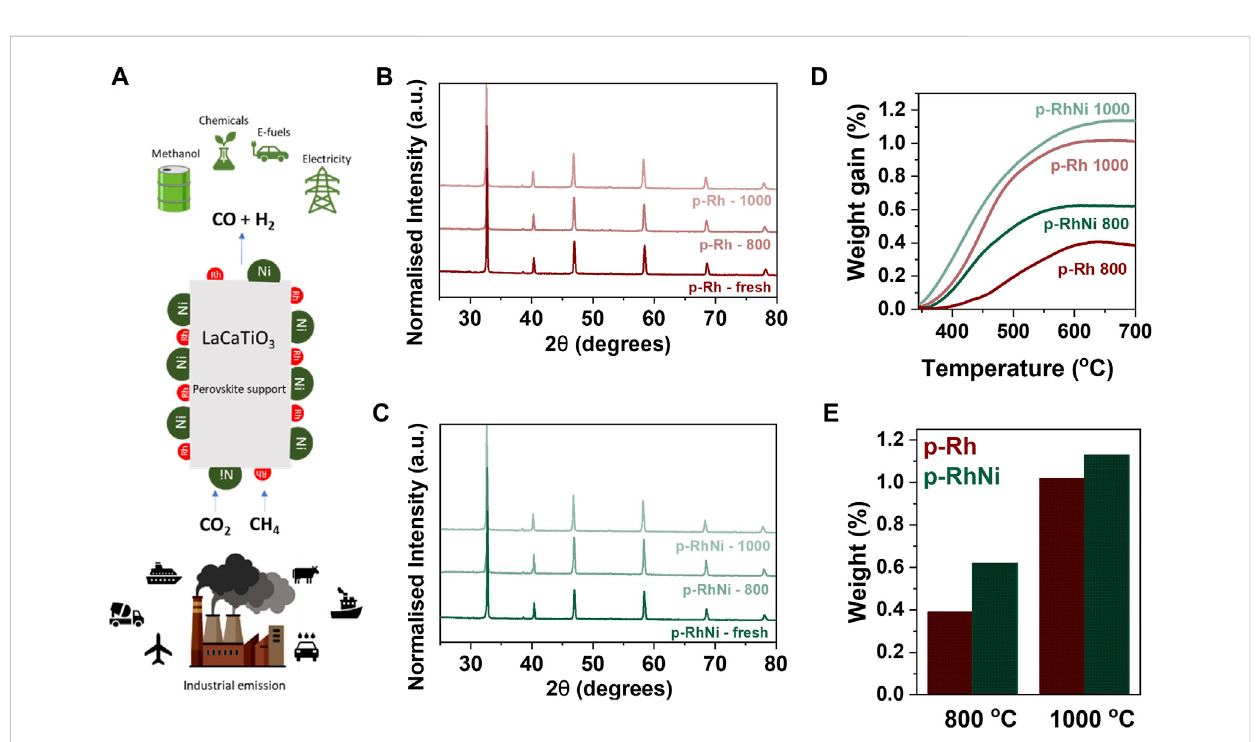
FIGURE 2 Provoking exsolution (A) Schematic representation of the concept of this work (B) XRD patterns of the undoped sample (C) XRD patterns of the Ni- doped samples (D) TGA curves of the reduced samples after oxidation (E) Quanti fi cation of the weight gained during oxidation/TGA experiments.